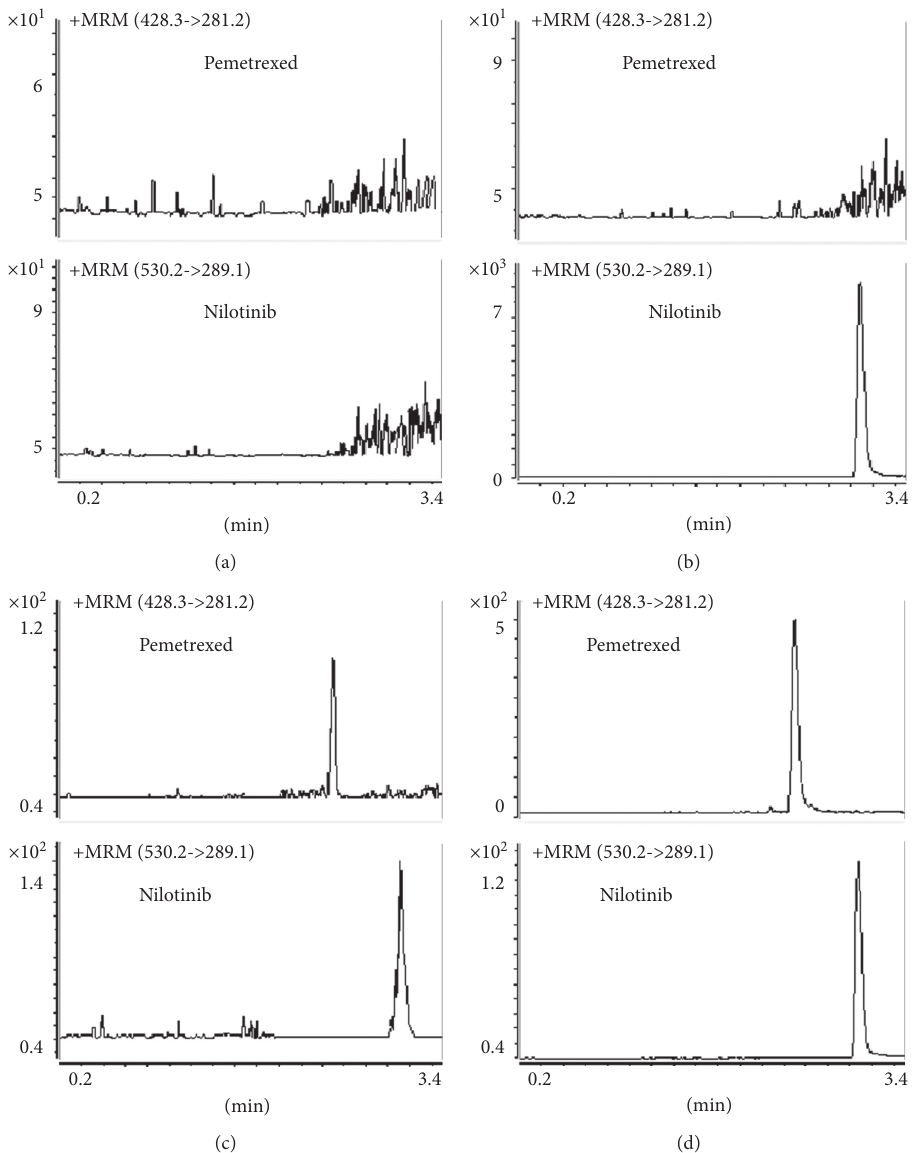
Figure 2: Chromatograms of pemetrexed and IS in different samples. (a) Blank sample. (b) Blank sample spiked with IS. (c) Blank sample spiked with LLOQ concentration of pemetrexed. (d) Real